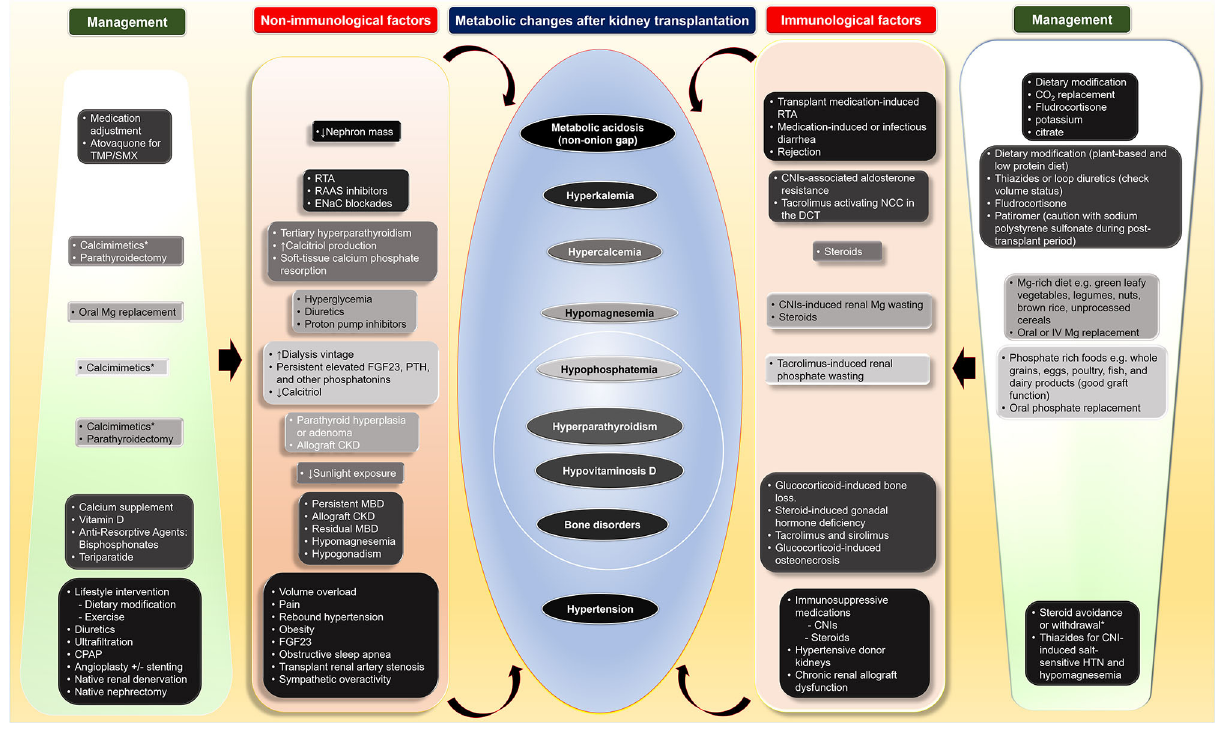
FIGURE 1 | Four main metabolic changes after kidney transplantation as non-immunological factors and their interconnection with immunological factors as well as therapeutic interventions including dietary modification, medical, and surgical treatments. CKD, chronic kidney disease; CNI, calcineurin inhibitors; CO 2 , total carbon dioxide; CPAP, continuous positive airway pressure; DCC, distal convoluted tubule; ENaC; epithelial sodium channel; FGF23, fibroblast growth factor 23; HTN, hypertension; IV, intravenous; MBD, mineral bone disorder; Mg, magnesium; NCC, thiazide-sensitive sodium-chloride cotransporter; PTH, parathyroid hormone; RAAS, renin-angiotensin aldosterone; RTA, renal tubular acidosis; TMP/SMX,